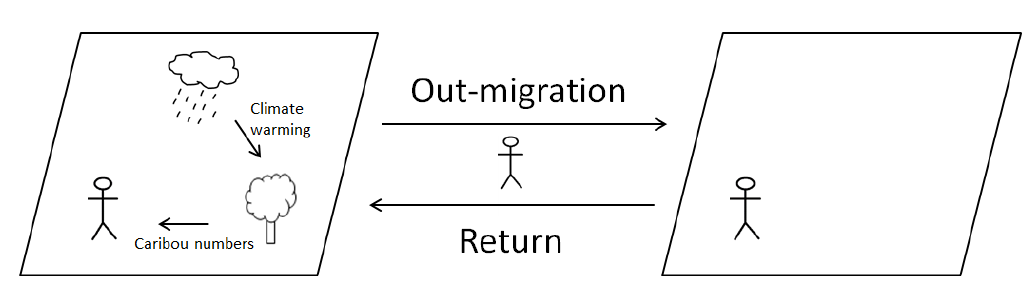
Fig. A1.1 Diagram drafted for the ABM described by Berman et al. (2004)